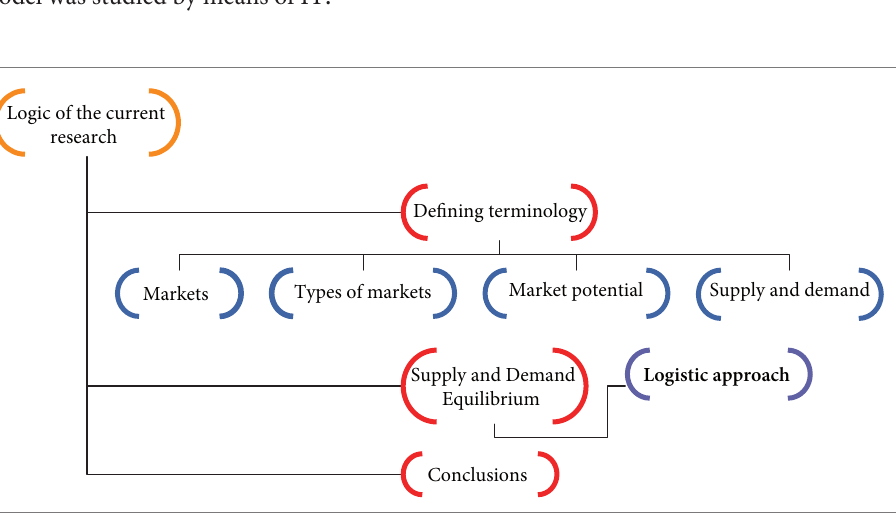
Fig. 1. Logic of the current